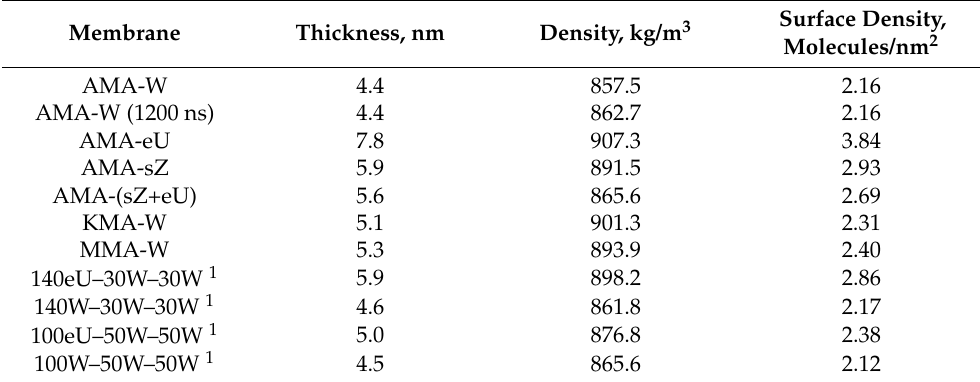
Table 2. Thickness and density of the AMA-based and mixed membranes after 300 ns of NPT MD (parameters determined on the basis of r 3